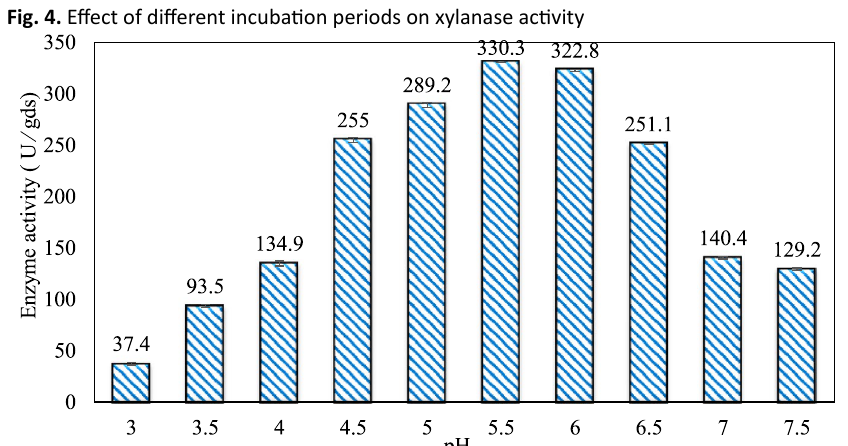
Fig. 5. Efect of different pH values on xylanase activity